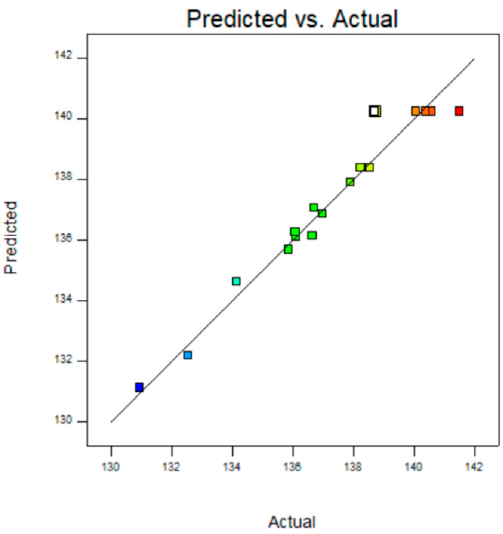
Figure 3. Predicted value and measured value of WCA.